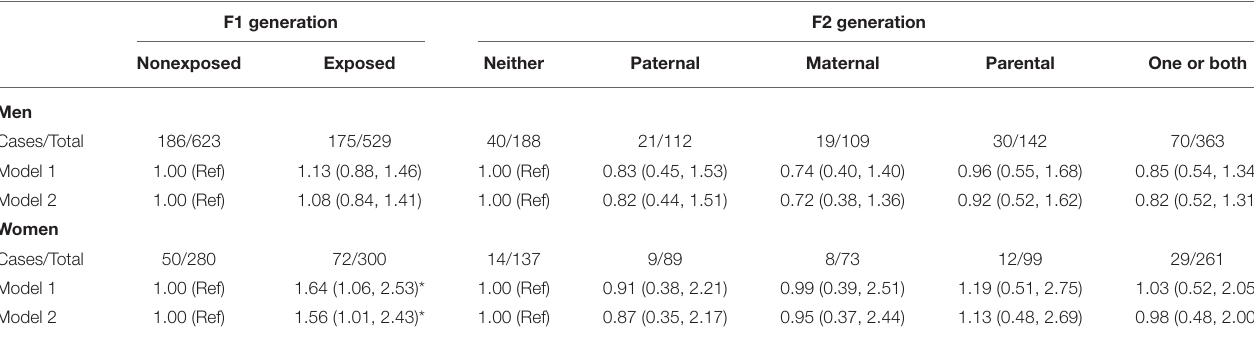
TABLE 3 | Odds ratios ( OR s) (95% CI ) for parental and offspring non-alcoholic fatty liver disease (NAFLD) among the different famine exposure groups. F1 generation F2